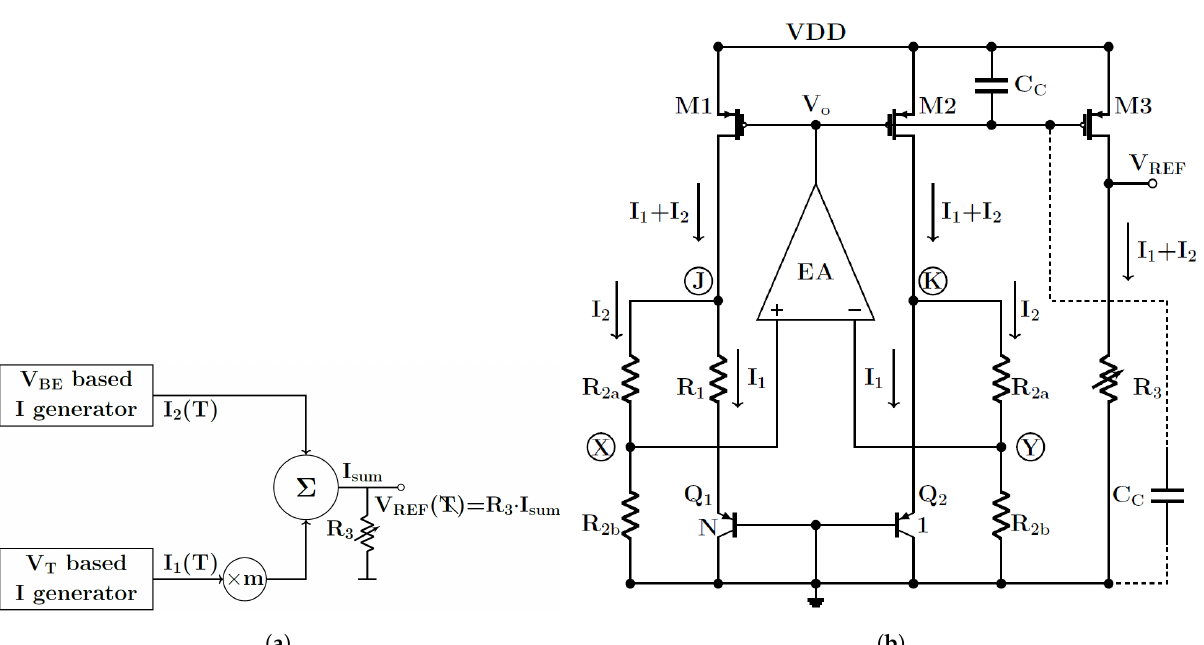
Figure 1. ( a ) Conceptual circuit of a current-mode bandgap. ( b ) Low-voltage bandgap schematic. C C connects V o with VDD (solid line) or GND (dashed line), depending on the PSR frequency